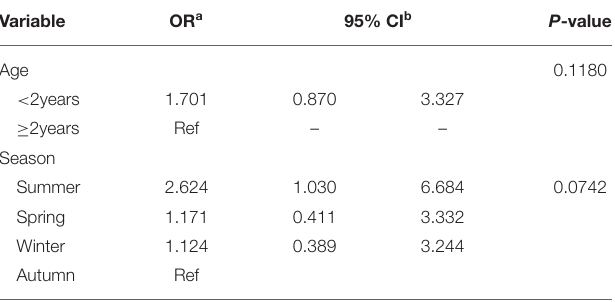
a Odds Ratio. b Confidence